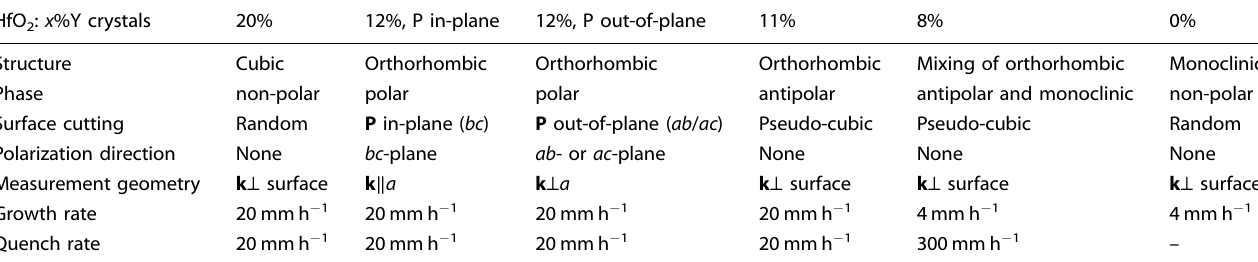
Table 1. Summary of HfO 2 single crystals with different Y